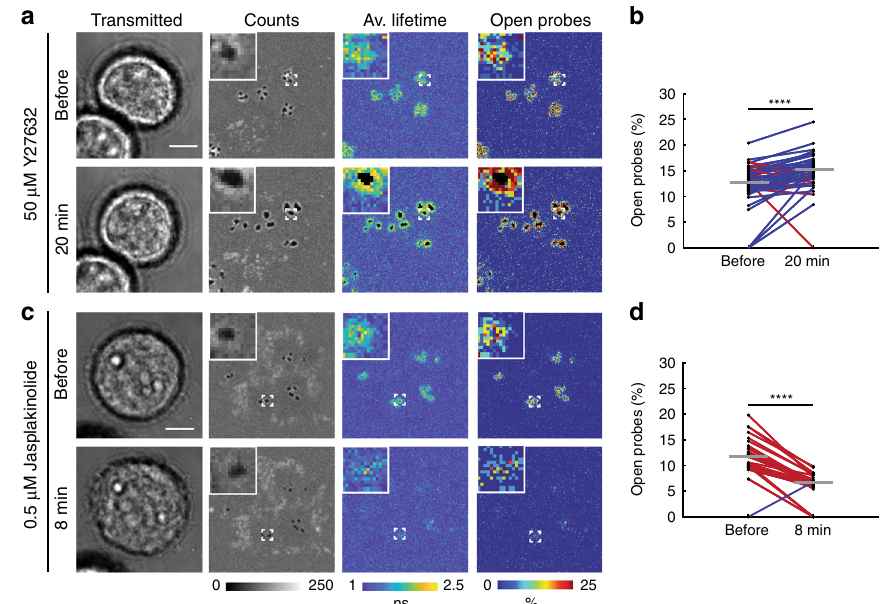
Fig. 4 Actin polymerization drives integrin tension. a , c Representative before and after MT-FLIM images of NIH 3T3 fi broblasts on 4.7 pN MT-FLIM probes treated with 50 μ M Y27632 or 0.5 μ M jasplakinolide, respectively. b , d Average percent open probes in podosomes per cell before and after drug treatment. Blue and red lines represent an increase or decrease in percent open probes per cell, respectively. Gray horizontal lines represent the median percent open probes. Statistics were performed with a two-tailed Wilcoxon matched-pairs signed rank test. At least 34 cells from three experiments were analyzed per condition. **** P < 0.0001. All scale bars, 5 μ m. Source data are provided as a Source Data fi Fig. 16g). The average podosome tilt angle per cell was 21° ± 2° from vertical. In comparison, integrins in fi broblast FAs on glass exert forces with a tilt angle of 40° ± 2° 49 . MFM has limited